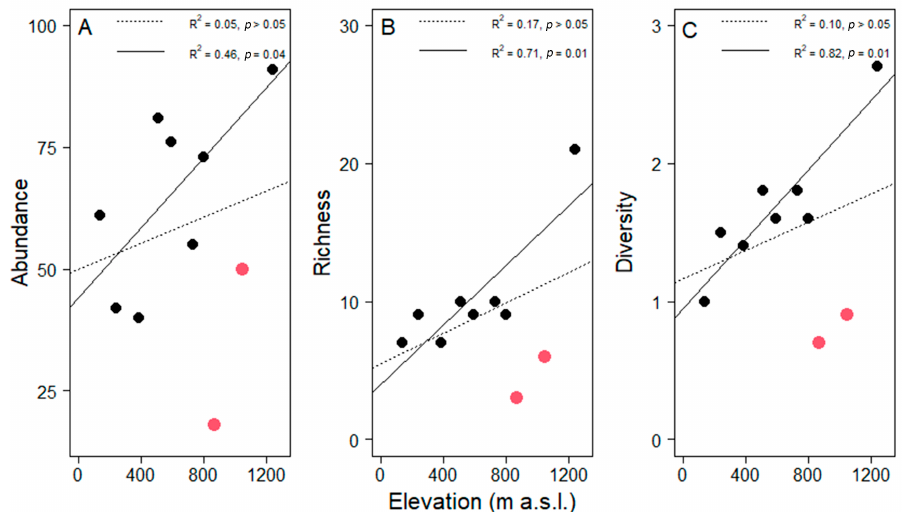
5. Figure 4. Variation in the average of ( A ) abundance, ( B ) richness and ( C ) diversity (as the Shannon index) of epiphyte assemblages in pasture trees ( n = 10 per plot) along the elevational gradient in Gualaca district. Dotted lines represent linear regressions including all plots. Solid lines represent the correlation without the plots at 870 and 1050 m a.s.l. (highlighted with red symbols). Coefficients of determination and probability values are given in each